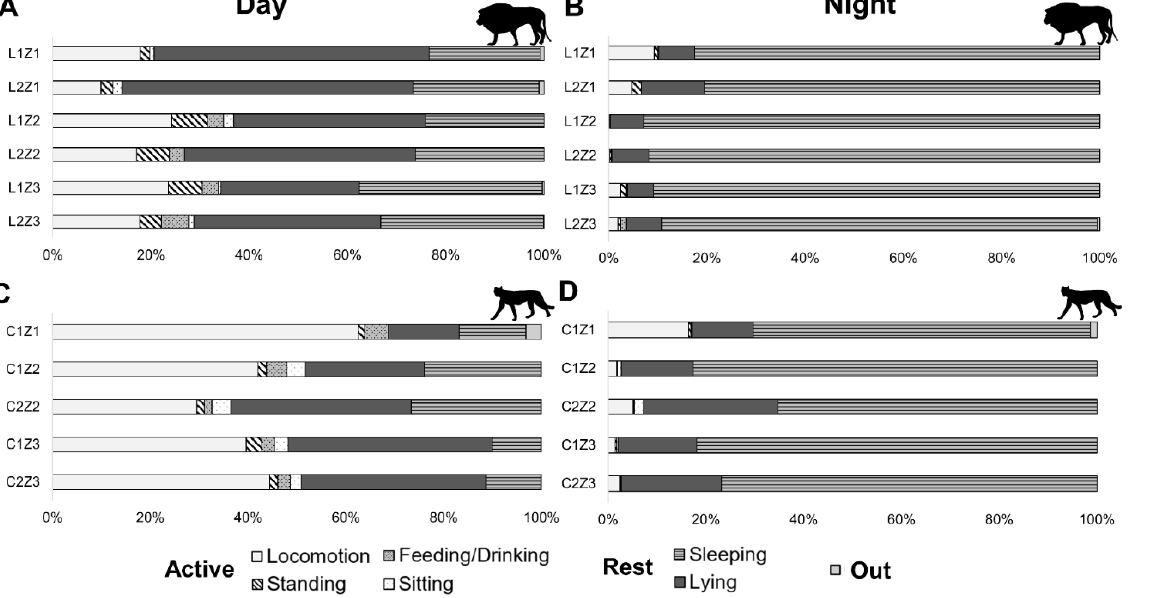
Figure 1. Diurnal (7am-7pm) and nocturnal (7pm-7am) activity budget across individuals and zoos: zoos: Percentages of behaviour states for lions ( A , B ) and cheetahs ( C , D ). The day phase is shown in Percentages of behaviour states for lions ( A and B ) and cheetahs ( C and D ). The day phase is shown the left column ( A , C ) and the night phase in the right column ( B , D ). For identification, individuals in the left column ( A and C ) and the night phase in the right column ( B and D ). For identification, were categorised as follows: individuals were categorised as follows: species/individual/zoo.